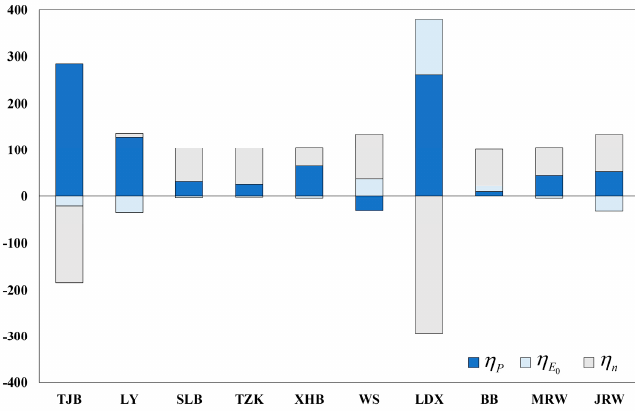
Figure 5. Attribution of R change from prior-impacted period-0 to post-impacted period-1.